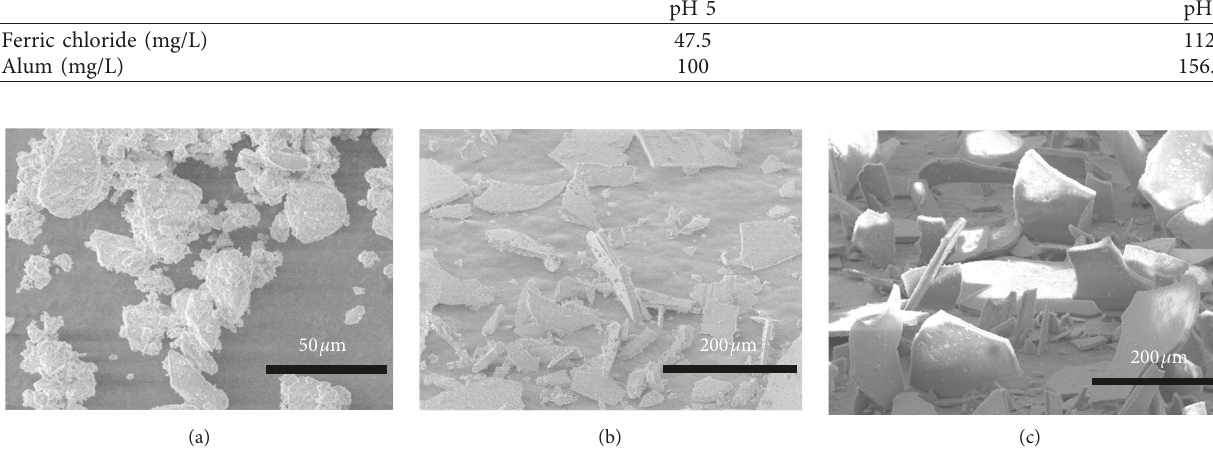
Figure 5: Scanning electron micrograph (SEM): (a) uncoagulated laterite particles, (b) coagulated laterite particles, and (c) coagulated and flocculated laterite particles.